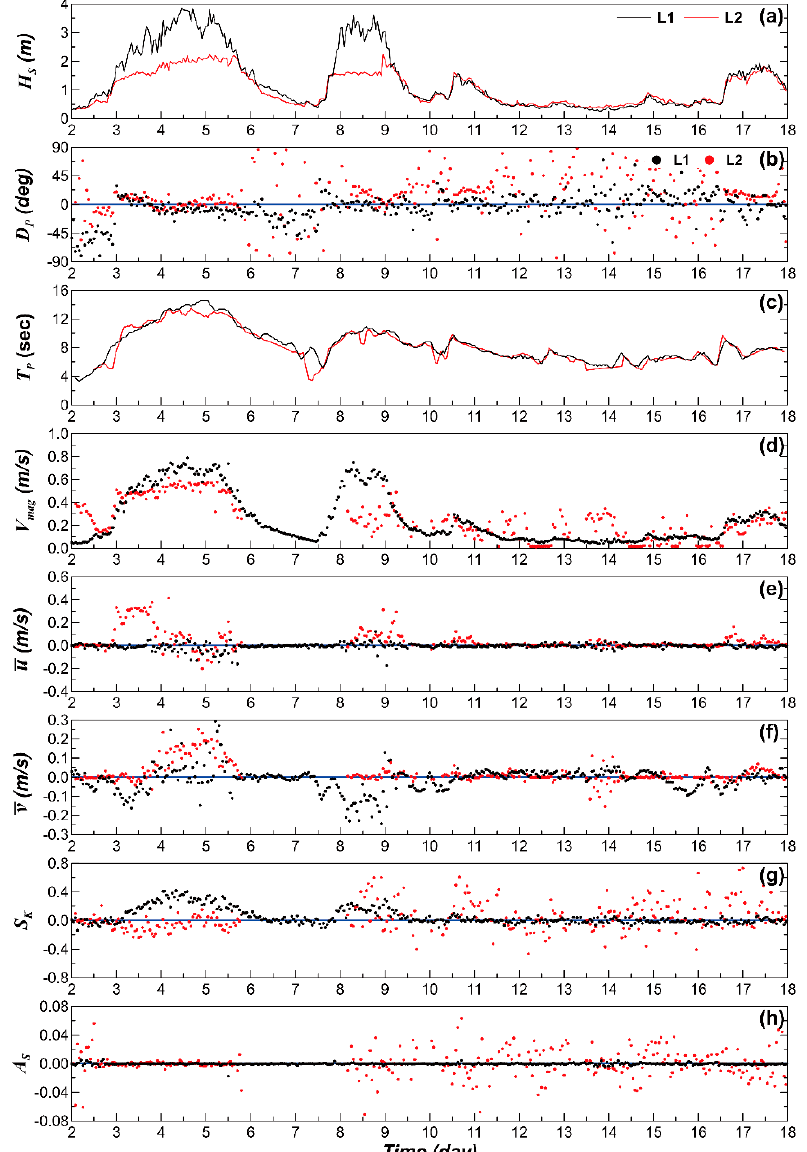
Figure 4. Wave and hydrodynamic parameters from 22 December 2016 to 7 January 2017 of Exp#1. ( a ) H s significant wave height, ( b ) D p : peak wave direction, ( c ) T p : peak wave period, ( d ) V mag : velocity magnitude, ( e ) u : cross-shore velocity ( + onshore), ( f ) v : longshore velocity ( + NW, left in the figure), ( g ) S k : wave skewness, ( h ) A s : wave asymmetry. The data of H s , D p and T p in L1 are taken from [19] .